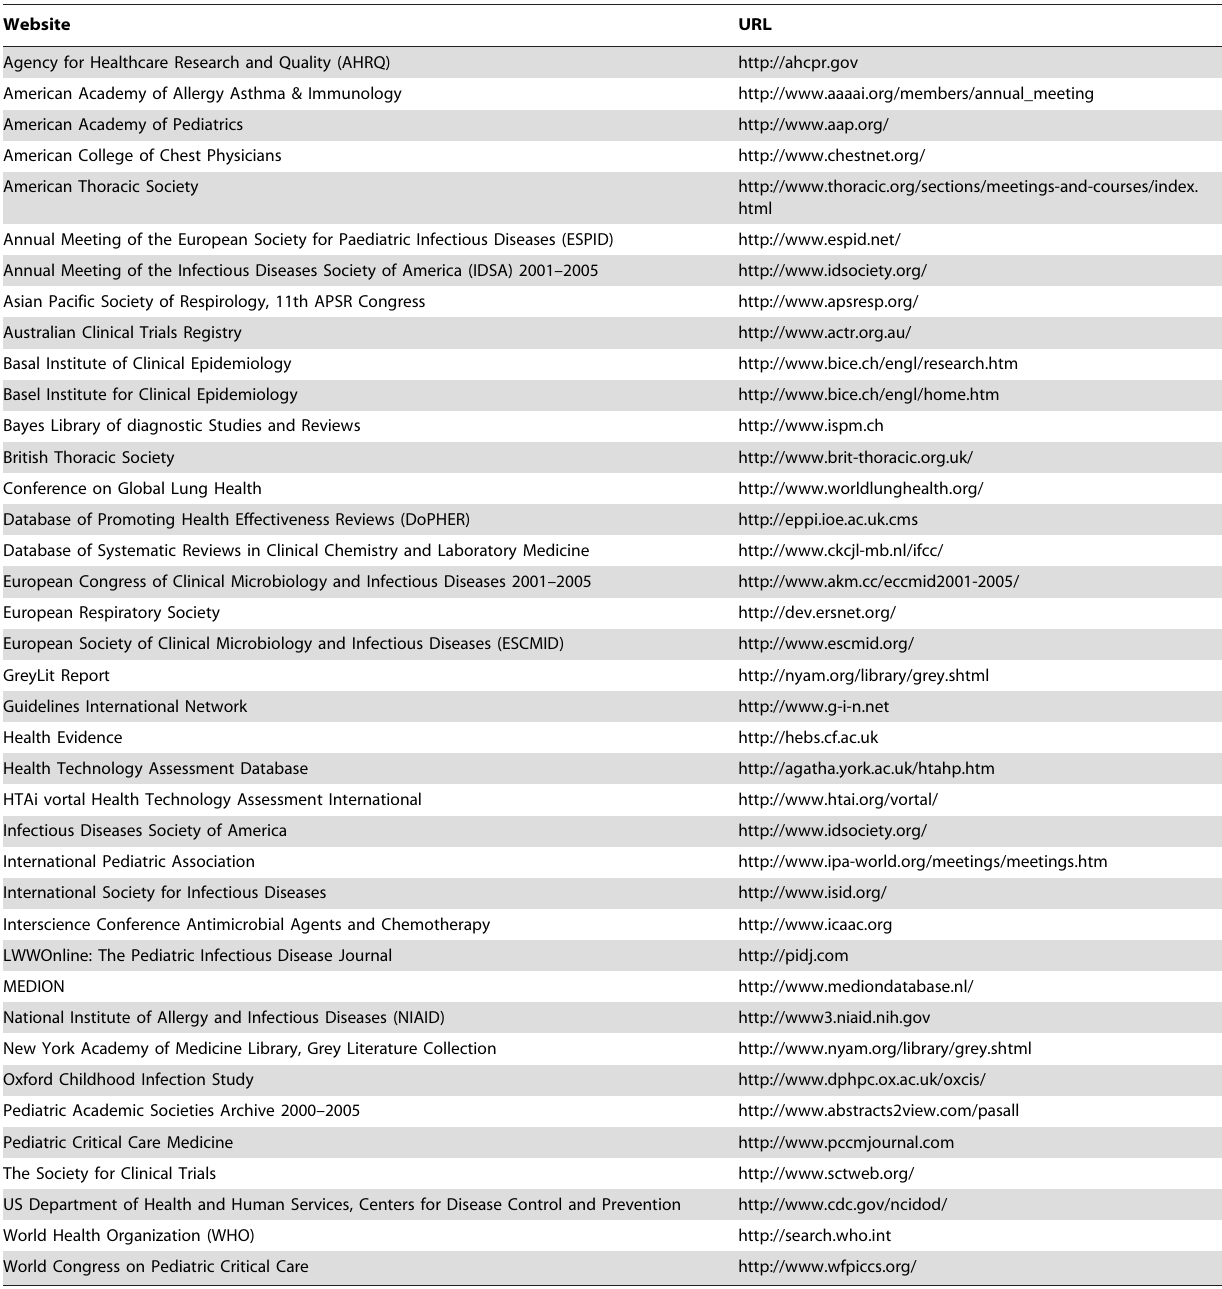
Table 2. Grey Literature Databases/Websites